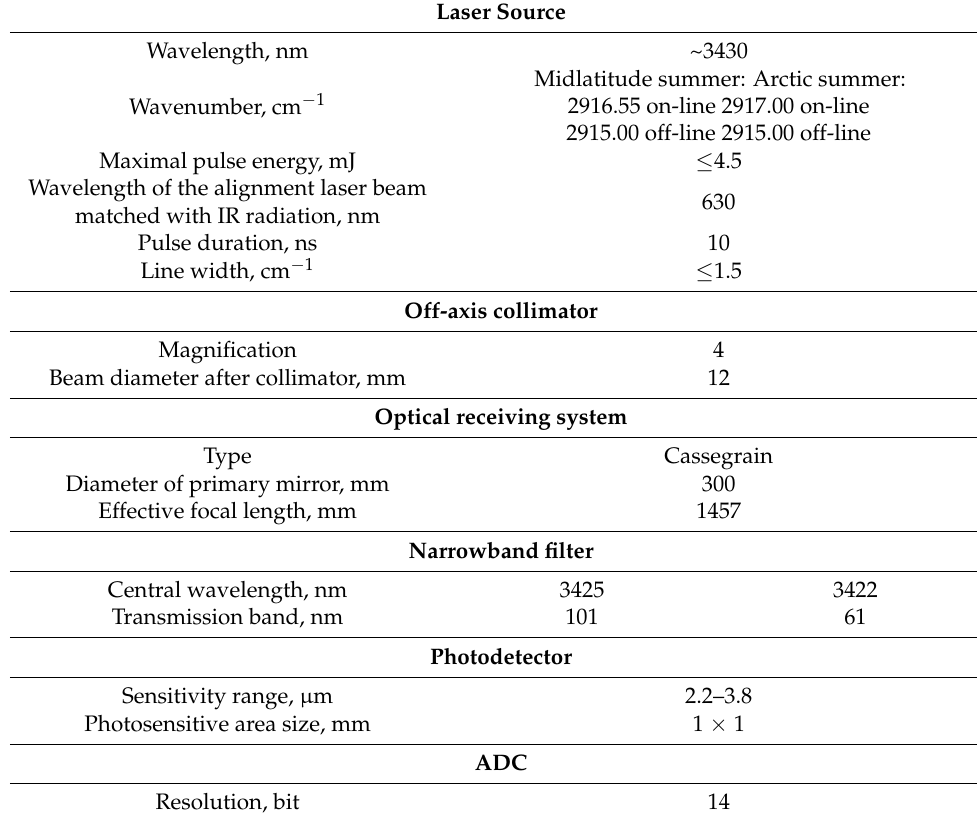
Table 1. Main parameters of the modernized airborne lidar.